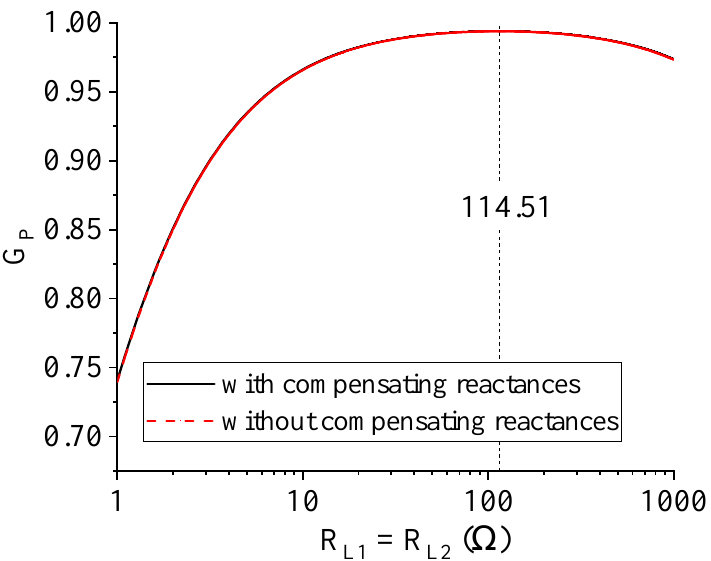
Figure 9. Case 2: efficiency calculated for Case 2 by varying R L while all the other parameters are set to the optimal values.